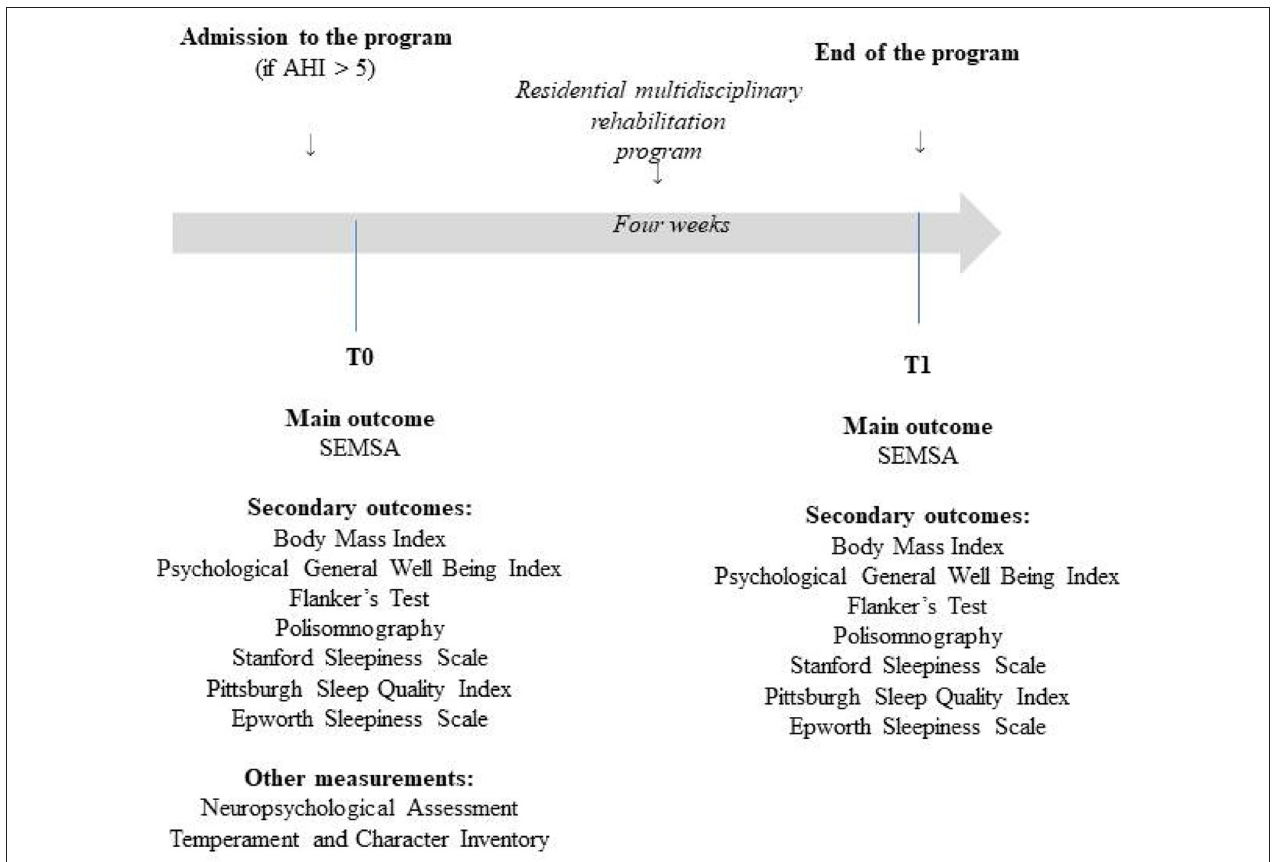
FIGURE 1 | Schematic representation of the